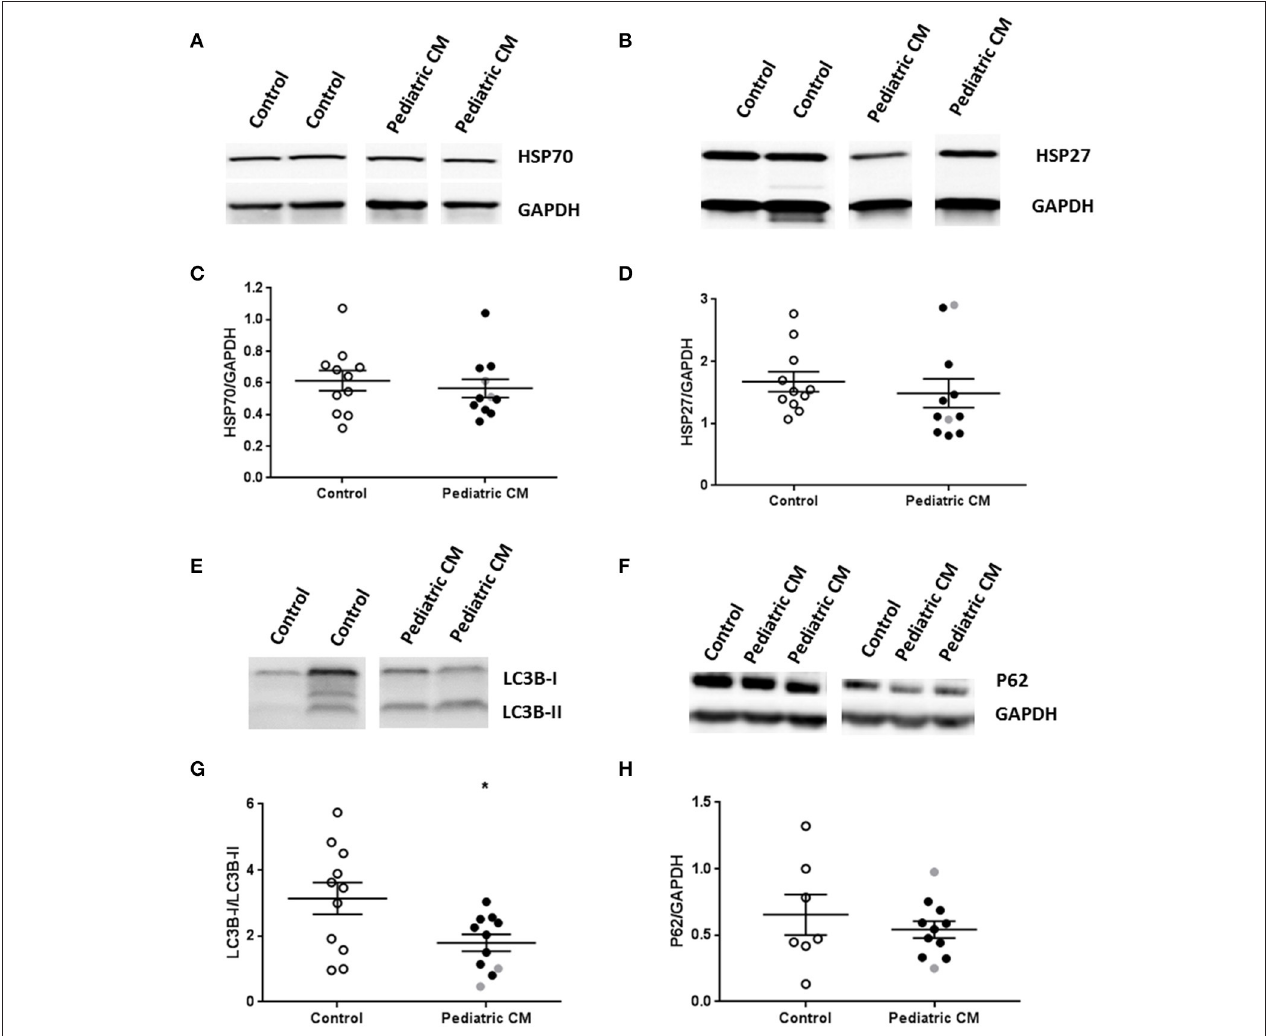
FIGURE 6 | Protein quality control system in pediatric CM. (A) Representative blot images for HSP27 expression. (B) Representative blot images for HSP70 expression. (C) Expression of HSP27 was not altered in pediatric CM ( N = 11) compared to controls ( N = 11). (D) Expression of HSP70 was not altered in pediatric CM ( N = 11) compared to controls ( N = 11). (E) Representative blot images for LC3BI and LC3B-II expression. (G) Expression of LC3B-I/LC3-BII was significantly ( p < 0.05) reduced in pediatric CM ( N = 11) compared to controls ( N = 11). (F) Representative blot images for p62 expression. (H) Expression of p62 was not altered in pediatric CM ( N = 11) compared to controls ( N = 7). GAPDH was used a loading control in the HSP27, HSP70, and p62 blots. Measurements obtained from samples derived from patients with non-compaction cardiomyopathy are indicated in gray. * p < 0.05, vs.